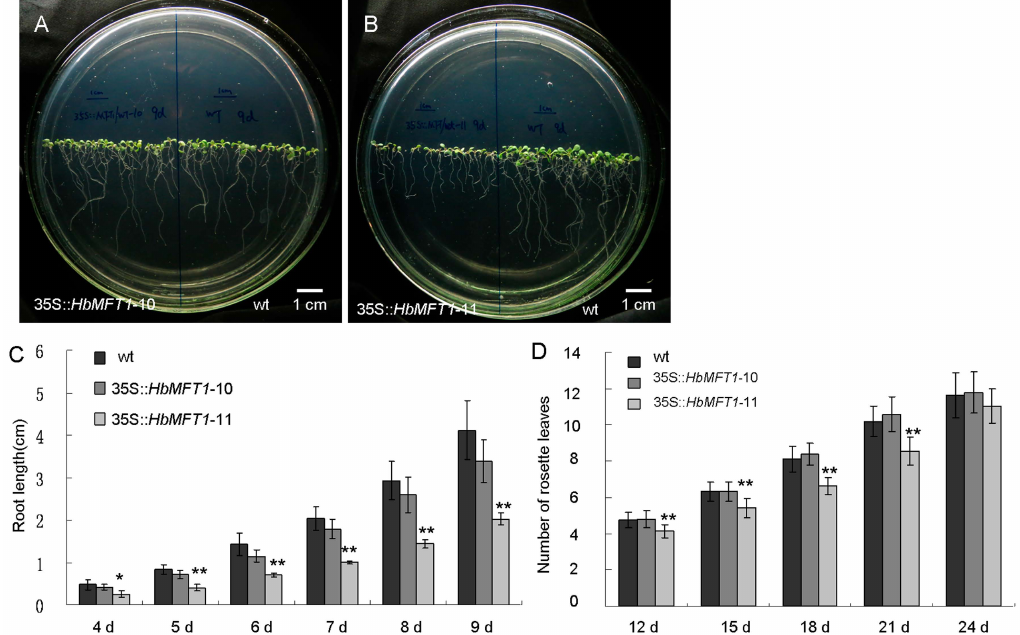
Figure 8. The effect of over-expressing HbMFT1 on aerial parts and roots growth. ( A , B ) Root growth observation for wt and 35S:: HbMFT1 transgenic lines; ( C ) Comparison of root length between wt and 35S:: HbMFT1 transgenic lines; ( D ) Comparison of rosette leaves between wt and 35S:: HbMFT1 transgenic lines. Significant difference tests were carried out using the Student’s t -test between wt and 35S:: HbMFT1 transgenic lines. The levels of significance: * indicates 0.01 < p < 0.05; ** refers to p <